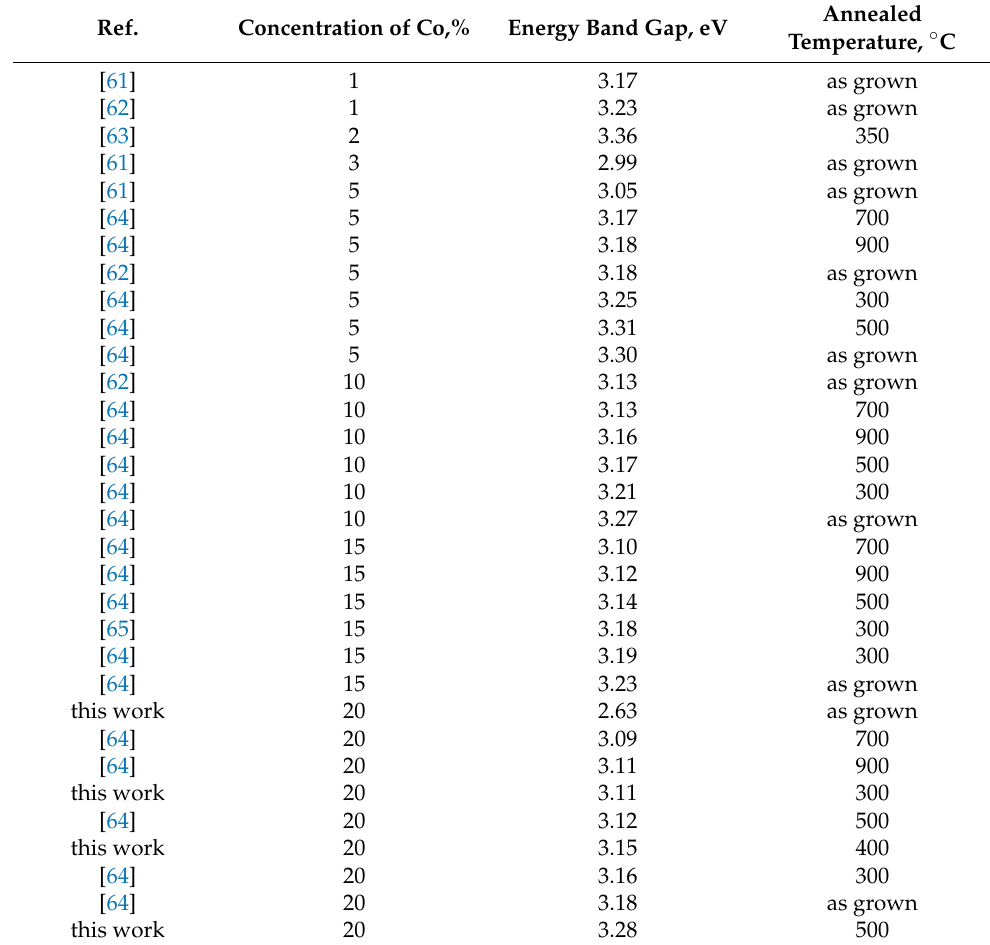
Table 3. Comparison of optical properties ( E g ) for samples with different cobalt content in ZnO lattice, annealed at various temperatures. Ref. Concentration of Co,% Energy Band Gap, eV